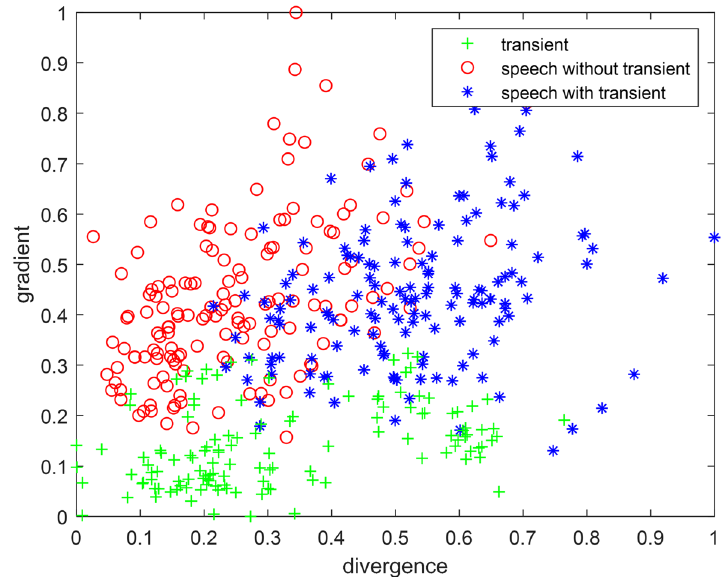
Fig. 6 The scatter plot of the gradient and divergence characteristics of graph signals. Red dots, blue dots, and green dots represent frames of speech without transients, speech with transients, and transients, respectively